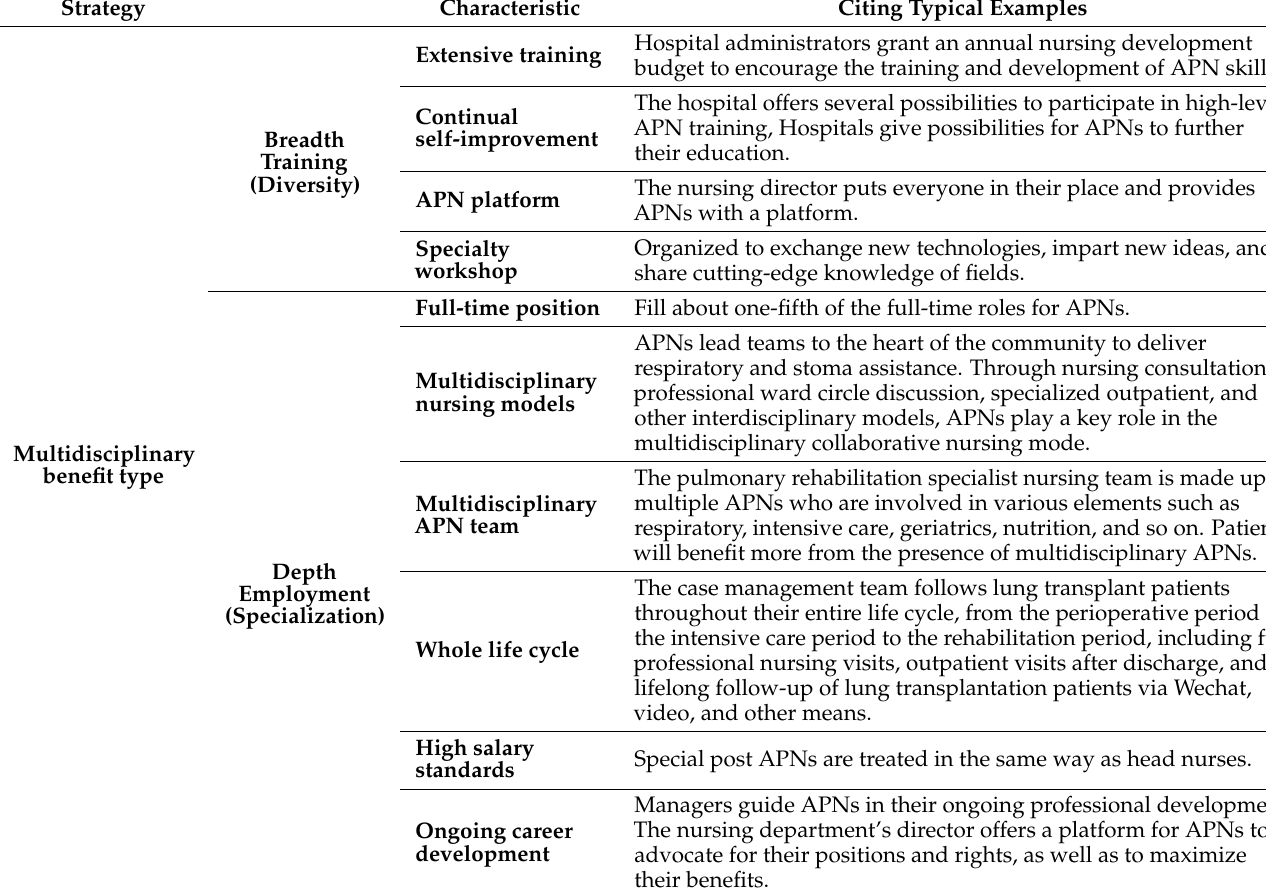
Table 6. Typical examples of management strategies of multidisciplinary benefit